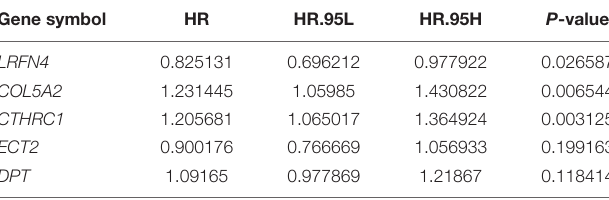
TABLE 1 | Prognostic value detection of the five genes in TCGA-STAD dataset. Gene symbol HR